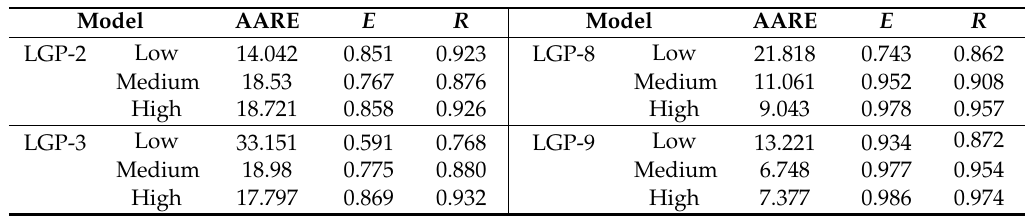
Table 8. Statistical parameters for low, medium, and high magnitude flows on the validation dataset of select models.